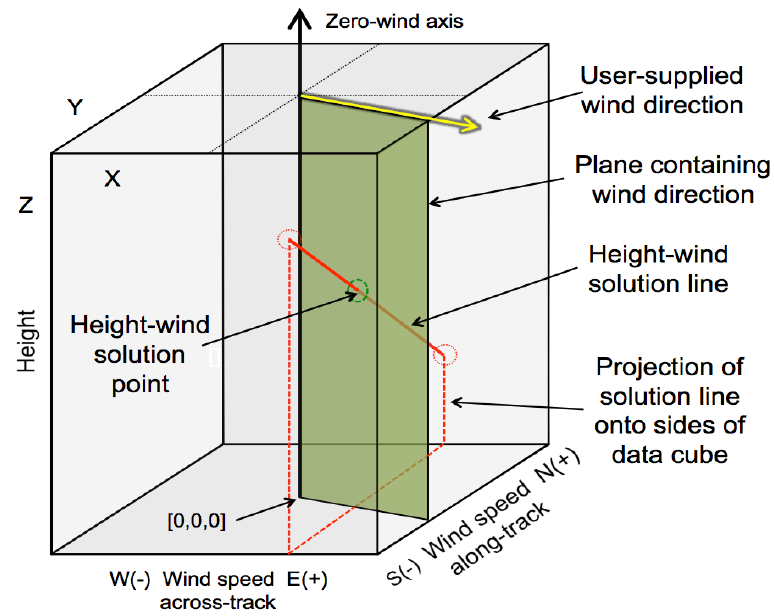
Figure 6. Data cube illustrating MINX forward-modeling results for stereo retrieval at one sample point and for one camera pair. Each point in the cube contains the difference between the measured disparity and the disparity that would be computed for that point’s height, across-track wind speed and along-track wind speed. The red line represents the infinite set of solutions for this camera pair; the green plane is constructed from the wind direction (yellow arrow) provided by the user; and the green oval at the intersection of the green wind-direction plane with the red solution line contains the height/wind-speed-across/wind-speed-along solution. Note that the solution line lies in a plane parallel to the along-track wind direction (YZ plane). The zero-wind height can be found at the intersection of the red solution line with a plane containing the zero wind axis and parallel to the across-track wind direction (XZ